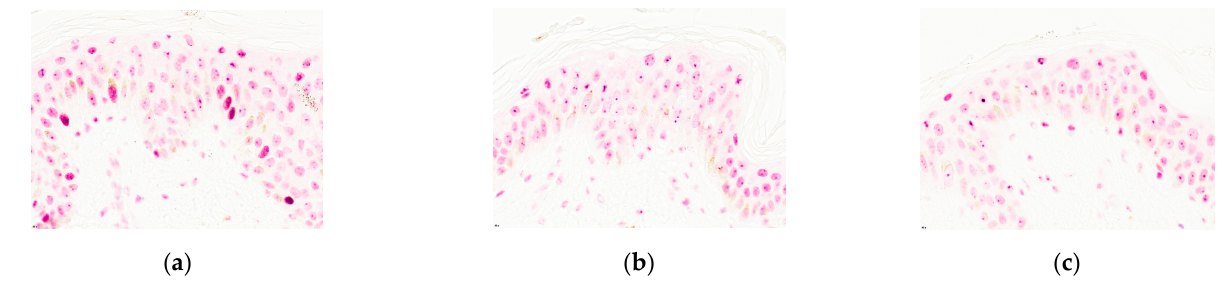
Figure 6. Nrf2 immunostaining of the batches irradiated with blue light ( a ), irradiated with blue light and pre-treated with the Melissa officinalis phytocomplex at 0.05% ( b ) or 0.1% w/v ( c ) on day 6.